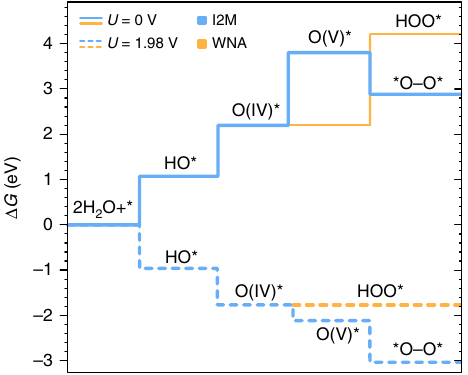
Fig. 6 Gibbs energy diagram for Ru-1 calculated at 0 V (solid lines) and 1.98 V (dashed lines) vs. RHE. Blue lines represent the I2M mechanism while the pale orange lines represent the conventional WNA mechanism